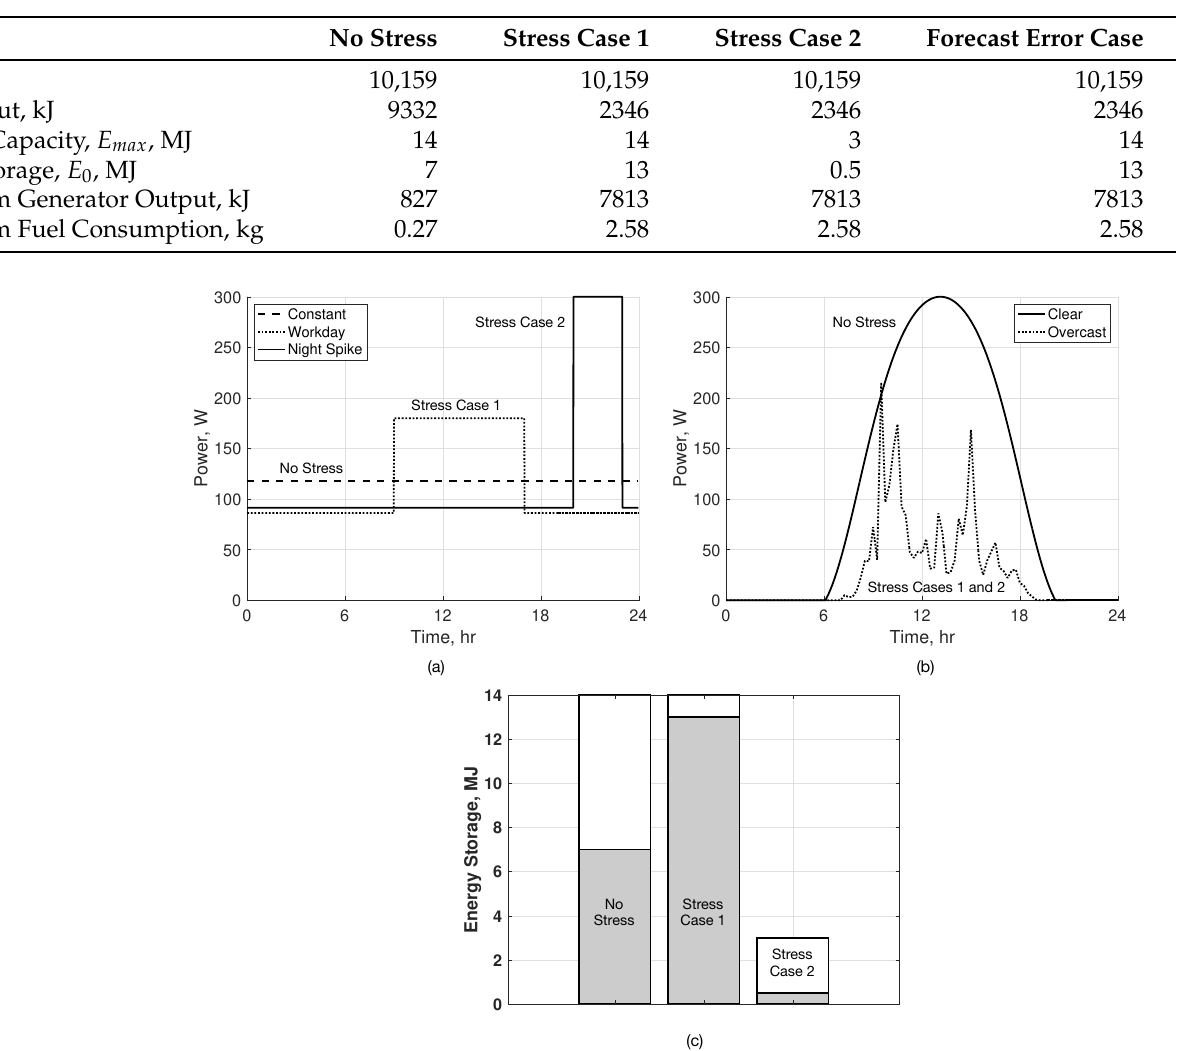
Figure 3. Electrical load, PV generation, and storage state cases used to create the three scenarios used in the case studies. The electrical loads ( a ) consume the same amount of energy, 10,159 kJ, in 24 h. The two PV generation scenarios, ( b ), are based on measured data for two extreme sky conditions: clear and overcast, producing 9332 kJ and 2346 kJ in 24 h. The energy storage bars, ( c ), show capacity, E max and initial states, and E 0 for the three cases.